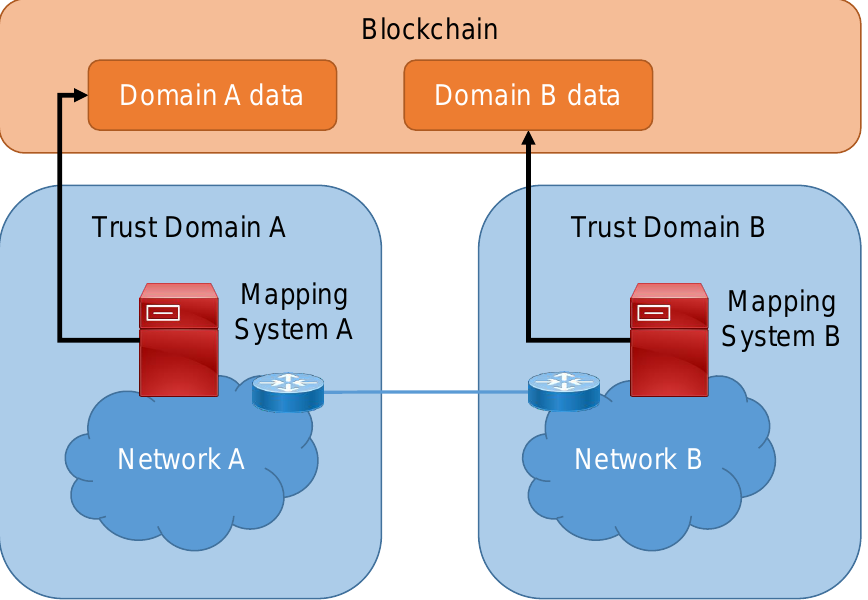
Figure 4. A blockchain can serve as a shared database between networks from different trust domains to share network